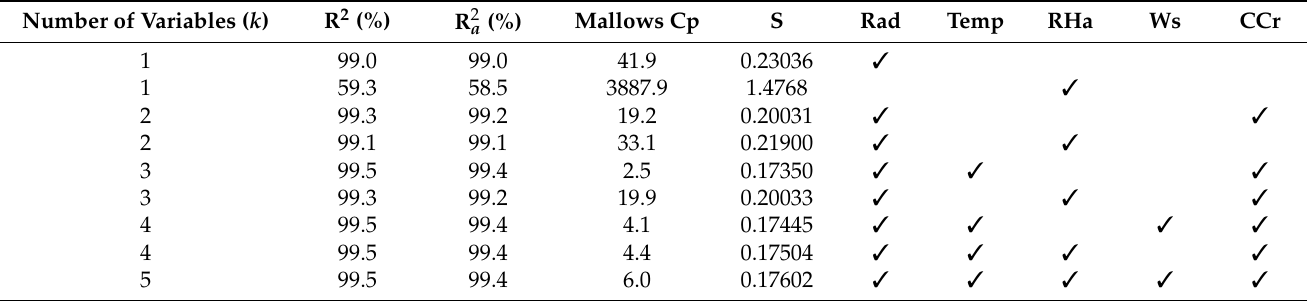
Table 7. Model statistics based on best subset selection.